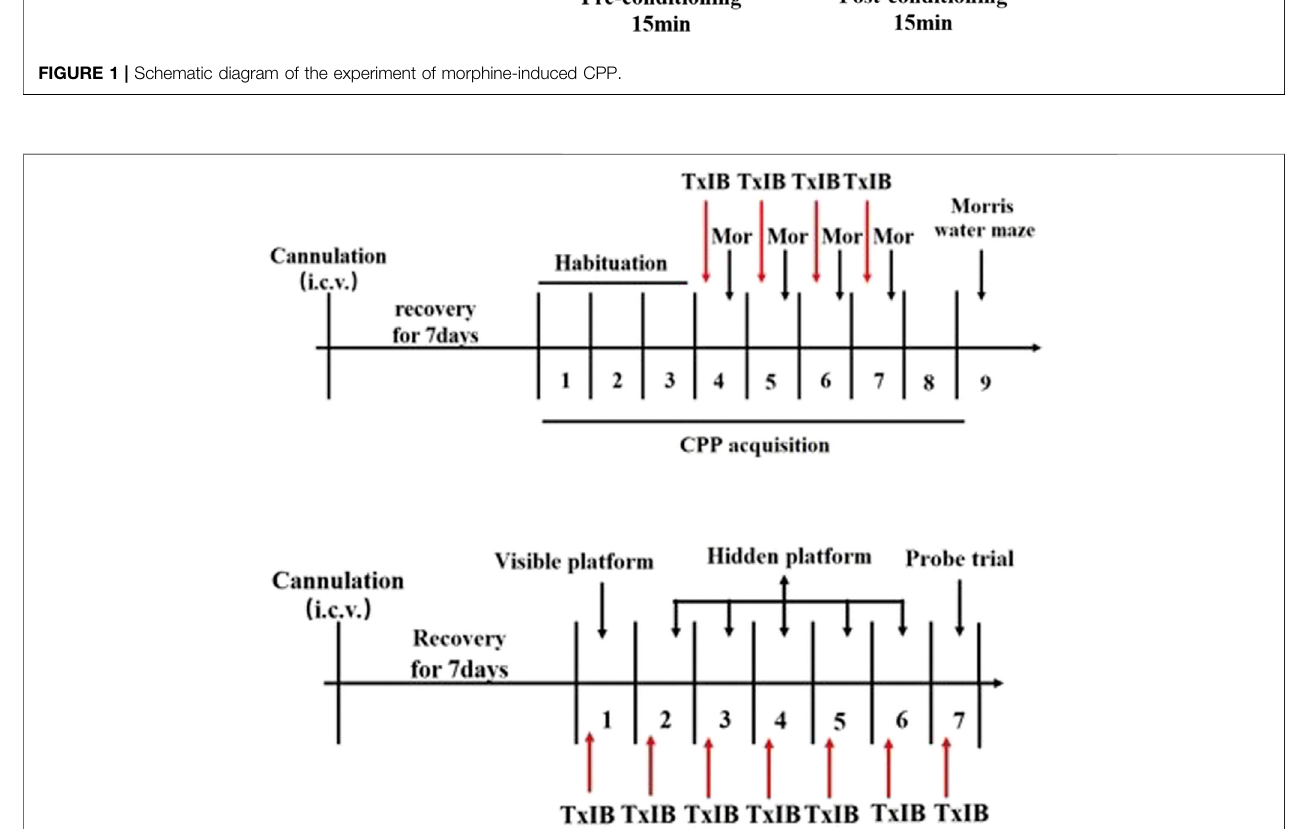
FIGURE 2 | Schematic diagram of the experiment of Morris water